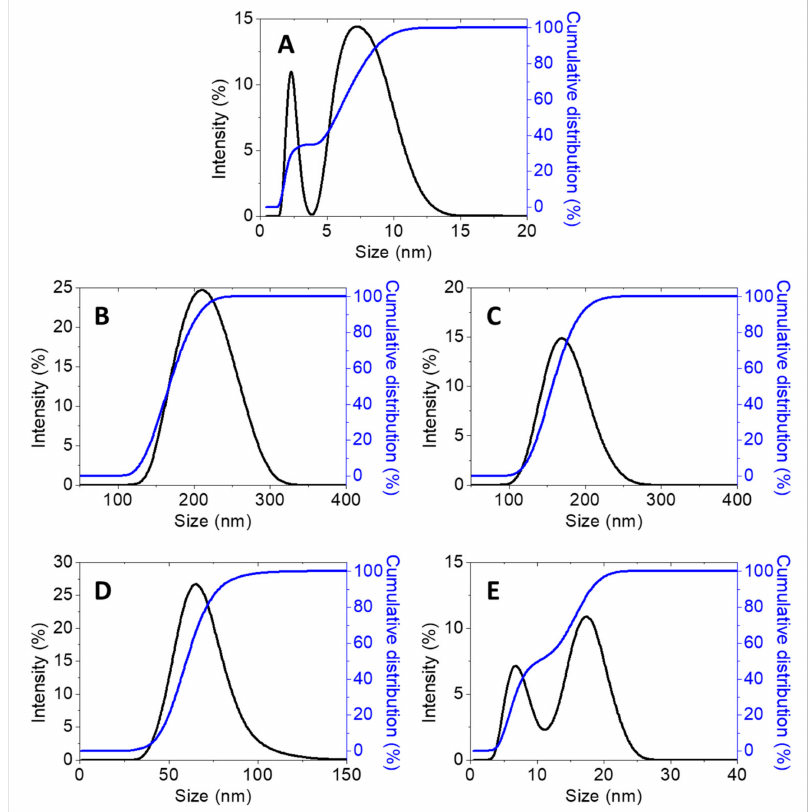
Figure 5. Cumulative and relative particles size distributions (PSD) of ( A ) CEN and chitosan– hexaconazole